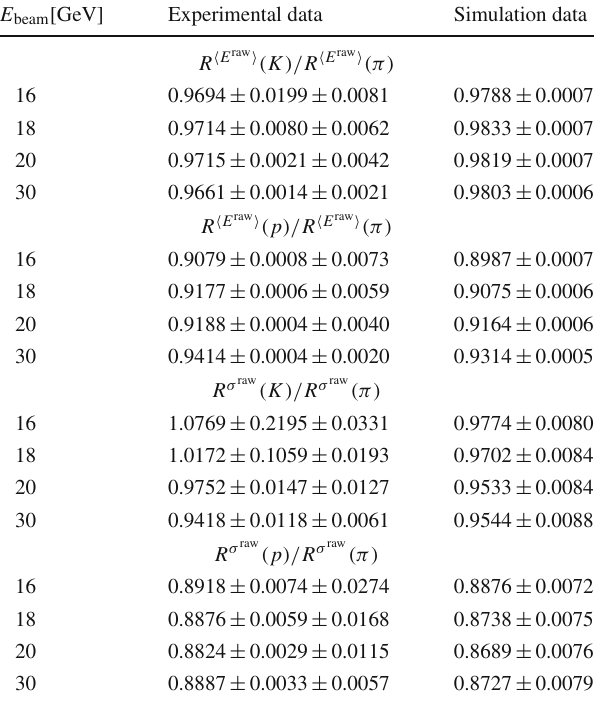
Table 9 Values of the ratios (14)–(17) obtained using experimental and simulated data produced by particles with E beam equal to 16, 18, 20 and 30GeV.Forexperimentaldeterminationsstatistical(firstvalue)andcor- related systematic uncertainties (second value) are reported separately.